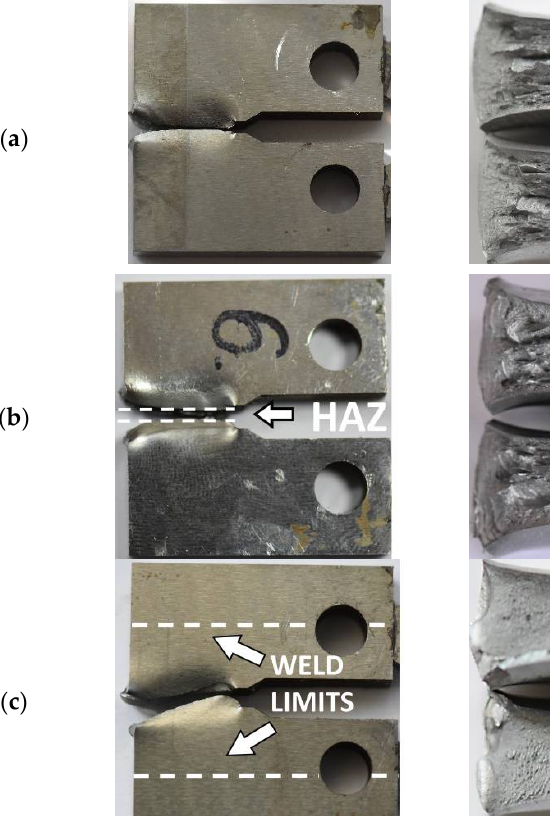
Figure 14. CT mini-specimens after CTOD tests: ( a ) parent material; ( b ) HAZ; ( c ) weld.